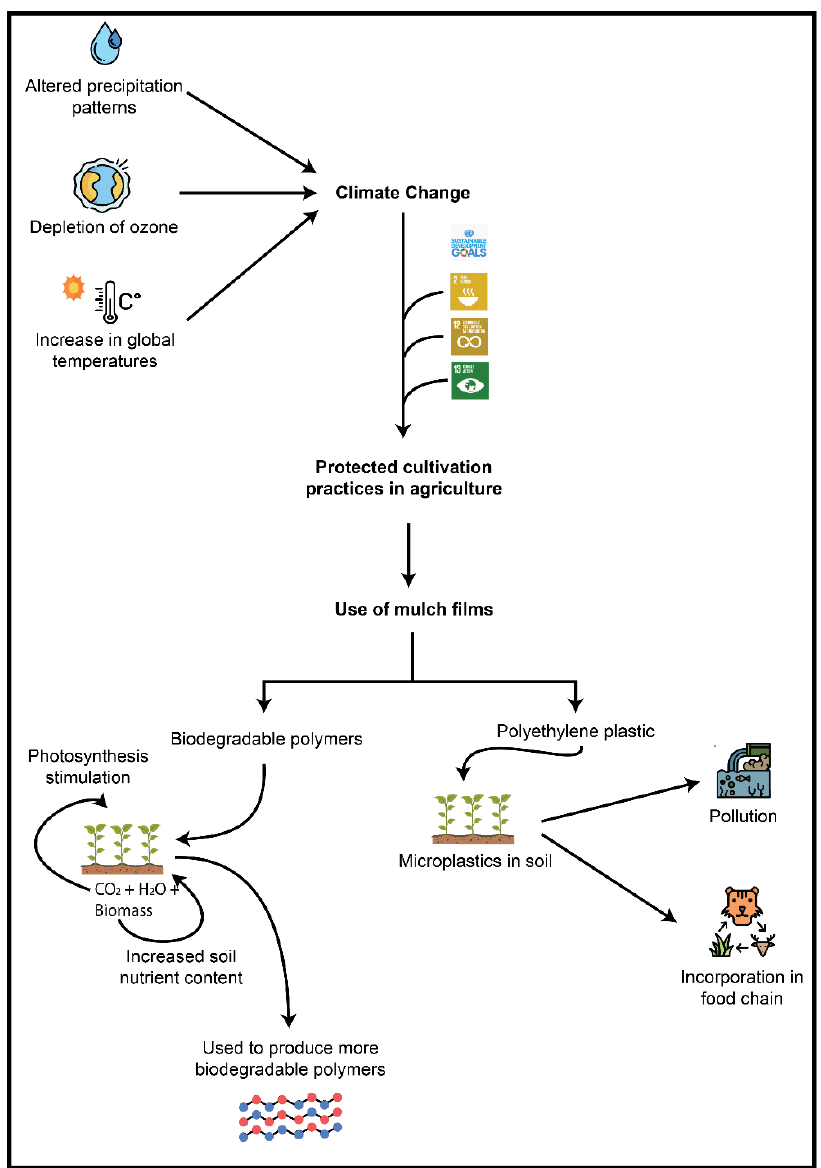
Figure 2. The need for mulching as an agricultural practice and the materials available for use as mulch films.